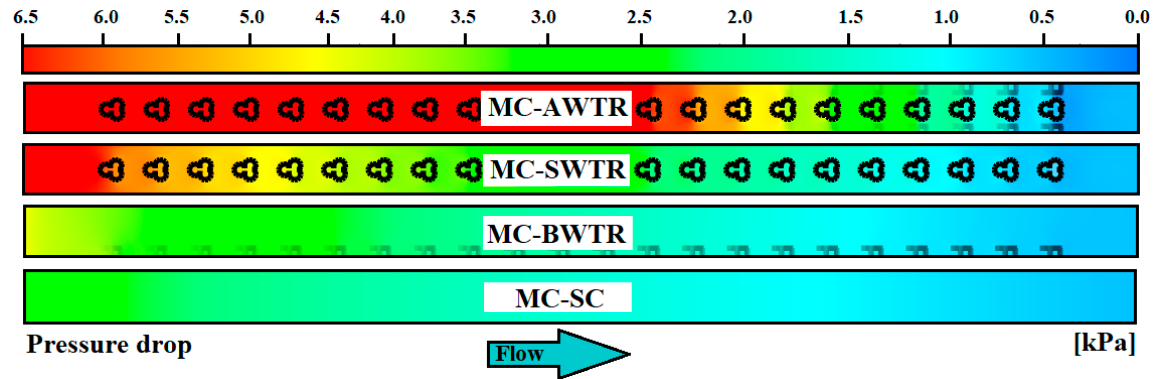
Figure 4. Pressure distribution of MCHS with trefoil shape ribs attached to different walls.